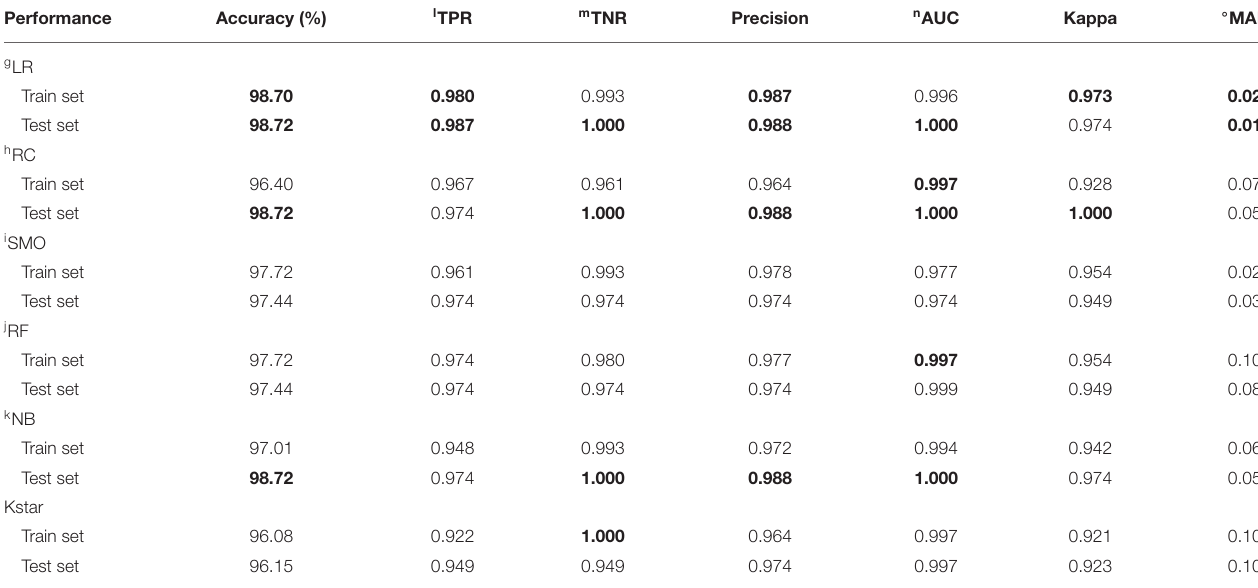
TABLE 2 | Performance metrics of 6 classifiers on the train set and test set.